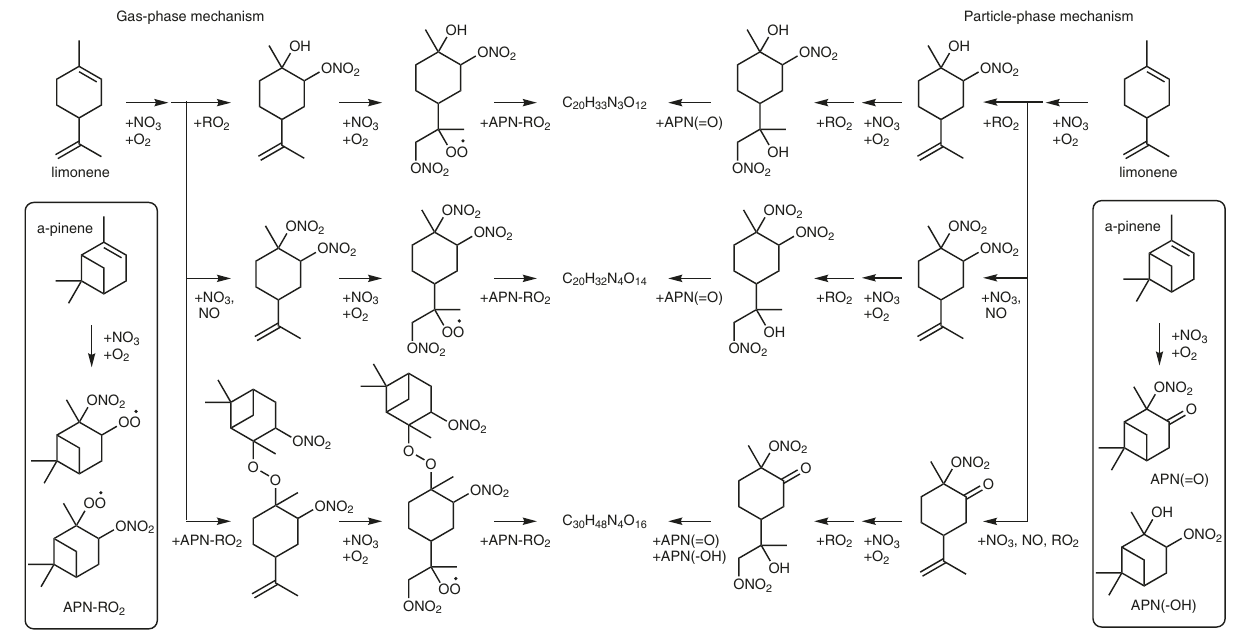
Fig. 3 | Proposed mechanisms for the formation of C 20 H 33 N 3 O 12 , C 20 H 32 N 4 O 14 , and C 30 H 48 N 4 O 16 in the simultaneous oxidation (MIX) experiment. Gas-phase mechanism via cross-reactions of α -pinene and limonene peroxy radicals (RO 2 · ), and particle-phase mechanism via hemiacetal formation involving α -pinene and